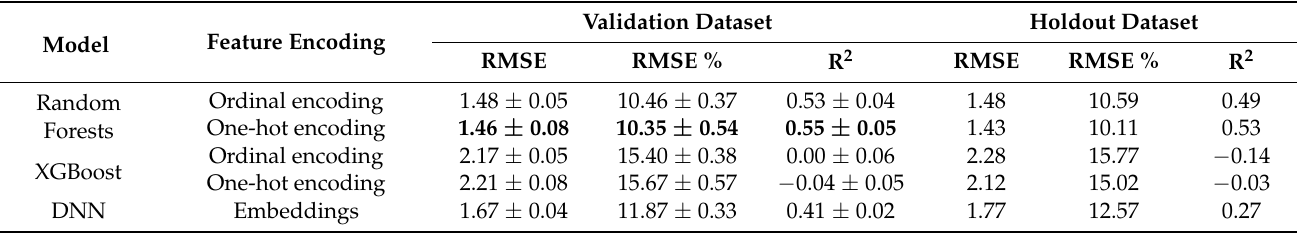
Table 2. Performance comparison of different machine learning models, using fivefold cross-validation. Values are presented with their standard variation. The best model’s result is highlighted in